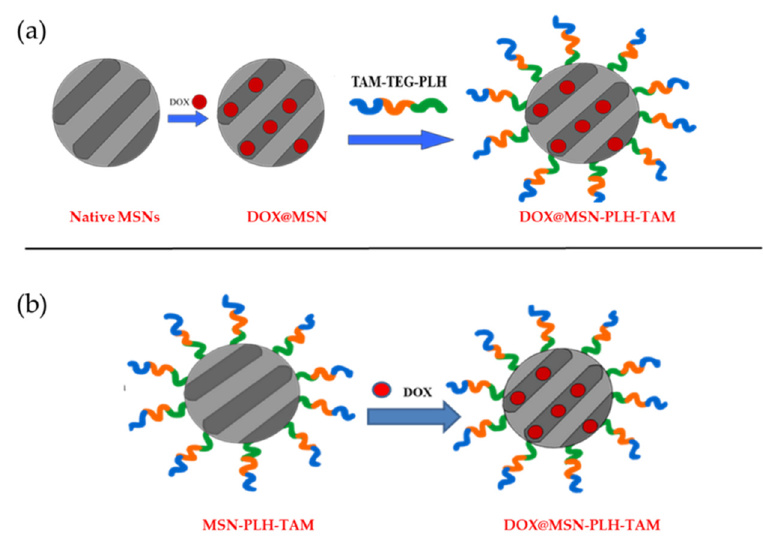
Figure 2. Illustration of the pre-grafting loading of MSN-based system. ( a ) MSNs were firstly loaded with DOX molecules, followed by surface functionalization to yield DOX@MSN-PLH-TAM in pre-loading grafting methods. ( b ) Fully functionalized MSN-PLH-TAM systems are loaded which DOX to form DOX@MSN-PLH-TAM in post-grafting-loading method.